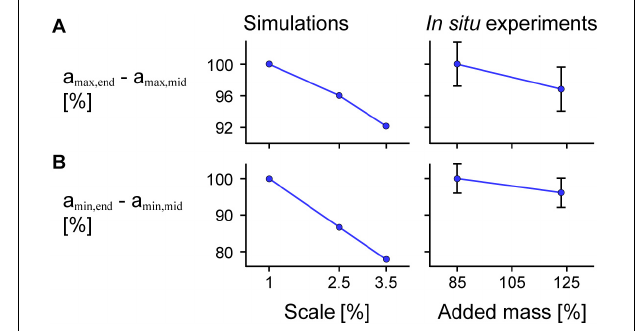
FIGURE 9 | Difference in maximum and minimum acceleration near the middle compared to at the end of the muscle across scales and added masses. Mean difference in maximum normalised acceleration in the x -direction at the end a max , end compared to that of a point near the middle of the muscle a max , mid across scales (muscle sizes) for simulations relative to scale 1 (left) and in situ experiments relative to 85% added muscle mass relative to the muscle mass (right; p = 0.0056) calculated across all maximum strains (A) . (B) Shows the mean difference in minimum acceleration a min , end in the x -direction at the end compared to near the middle of the muscle a min , mid ( p = 0.0076 for the in situ experiments). a max , end and a min , end were normalised to the muscle optimal length and a max , mid and a min , mid were normalised to the x distance between the centre point and the moving end of the muscle at rest for the simulations and between the inserted pin and the moving end of the in situ muscle at rest for the experiments. Although we show similar trends for greater added mass as for greater scale, we caution against directly comparing the magnitude of effects as altering the added mass and scale manipulate the tissue mass in different ways. The initial pennation angle β 0 was 15.3 ◦ and the maximum normalised excitation was 1 for the simulations and the in situ muscle was supramaximally stimulated to activate all the muscle fibres. The error bars for the in situ experiments represent the standard error of the mean. Note that the lines connecting discrete points are intended to aid in visualization rather than to imply a linear